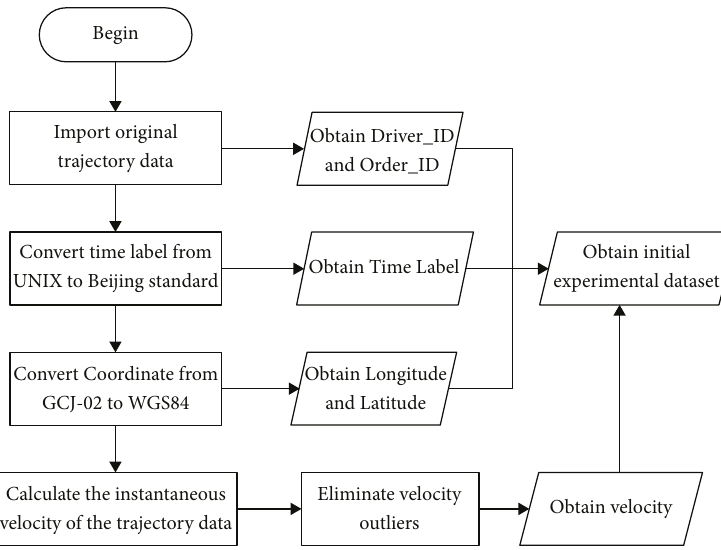
Figure 5: The preprocessing of the original trajectory